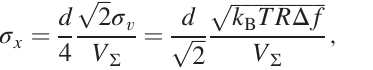
FIG. 5. Histograms of the estimated horizontal (left) and vertical (right) BPM noise corresponding to the case of Au-Au operation with a bunch intensity of 0 . 48 × 10 9 in Fig. 4.